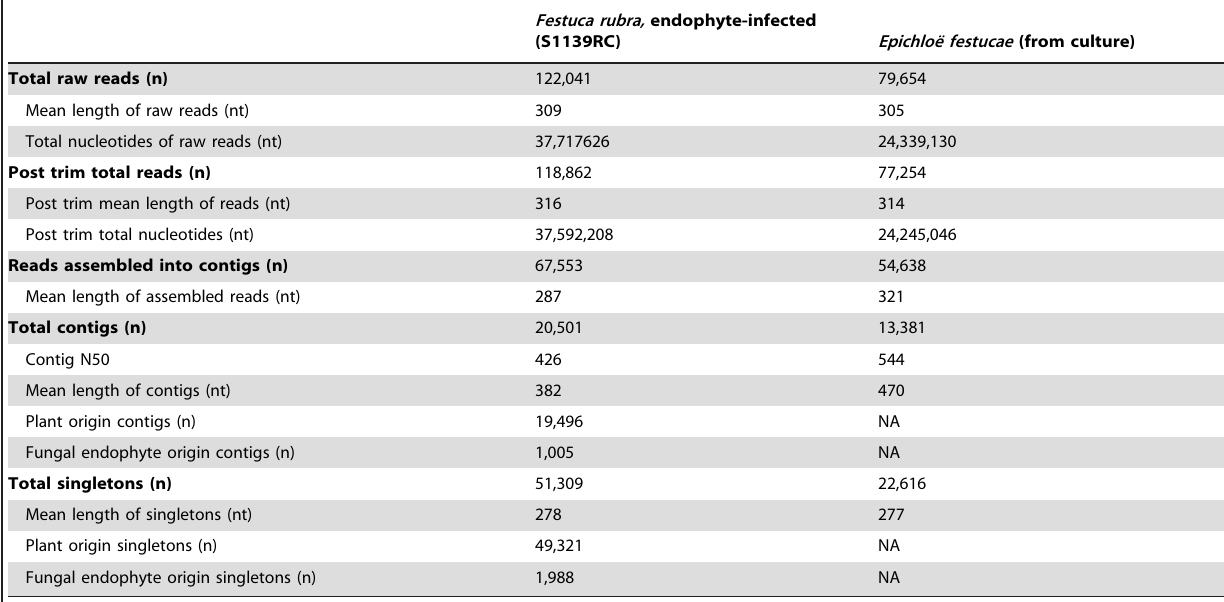
Table 1. Characteristics of the 454 sequences.